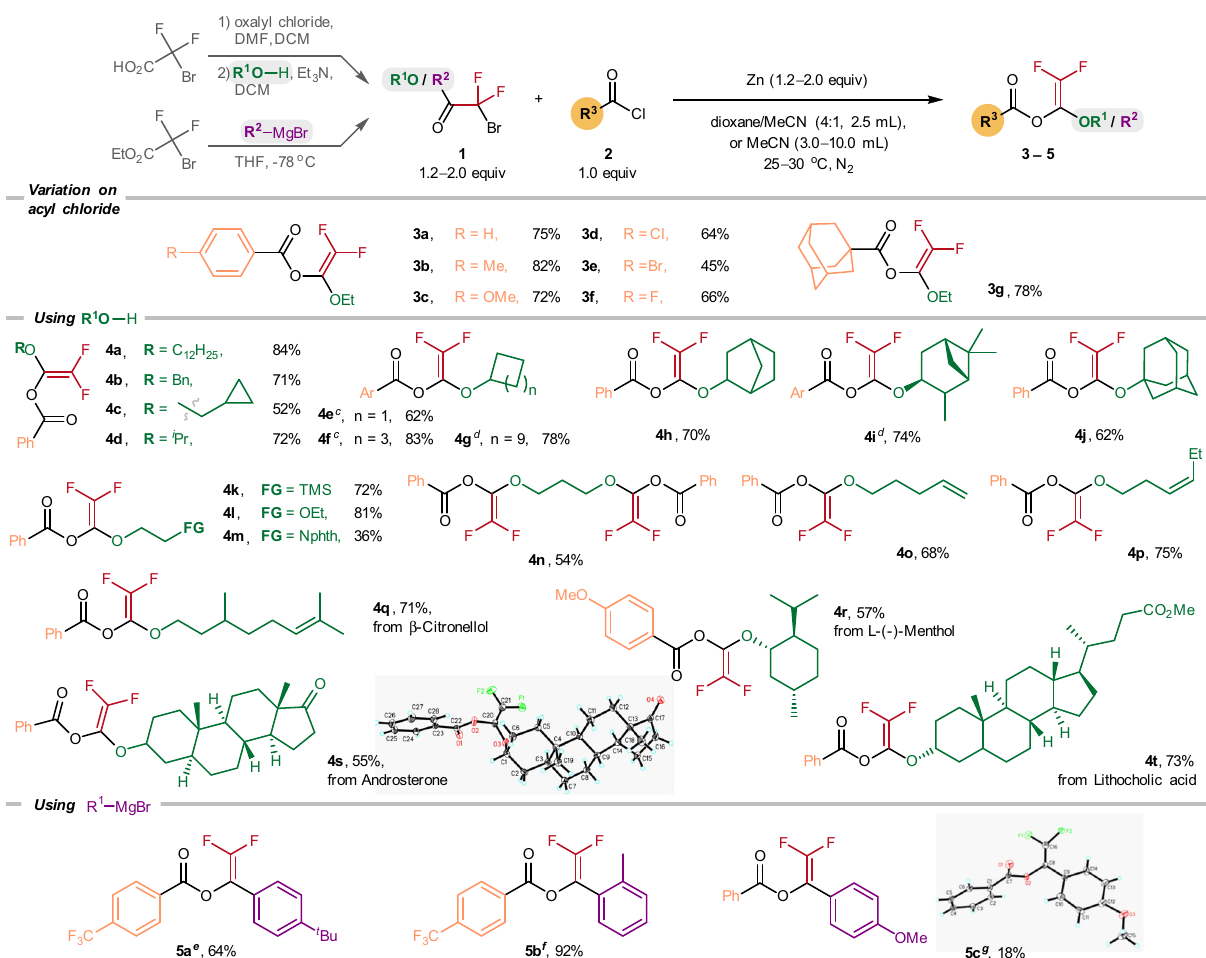
Fig. 2 Scope of 2,2-di fl uorovinyl benzoates (BzO-DFs) 2. a Reaction conditions: 2-bromo-2,2-di fl uoroacetates (2.0 equiv), acyl chlorides (0.5 mmol), and Zn (2.0 equiv) in 2.5 mL dioxane/MeCN (4:1 v/v ) at 30 o C, 12 h, N 2 . b Isolated yields. c Ar = Ph. d Ar = 4-MeOC 6 H 4 . e 1o (3.0 equiv), 4-(tri fl uoromethyl) benzoyl chloride (0.2 mmol), Zn (3.0 equiv) in 3.0 mL MeCN at 25 o C, 10 h, N 2 . f 1p (1.5 equiv), 4-(tri fl uoromethyl)benzoyl chloride (0.2 mmol), Zn (2.0 equiv) in 3.0 mL MeCN at 25 o C, 10 h, N 2 . g 1n (1.2 equiv), benzoyl chloride (2.0 mmol), and Zn (1.2 equiv) in 10.0 mL MeCN at 25 o C, 5 h, N 2